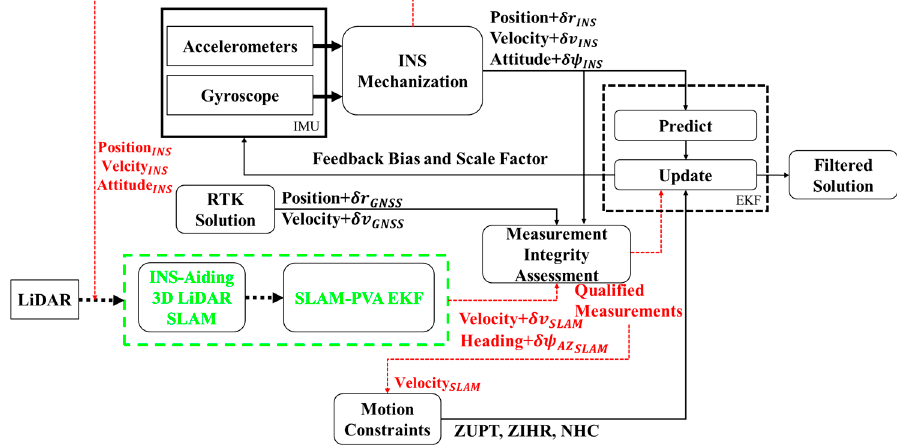
Figure 1. Flowchart of the inertial navigation system (INS) / global navigation satellite system (GNSS) / 3D light detection and ranging-simultaneous localization and mapping (LiDAR-SLAM) fusion design.